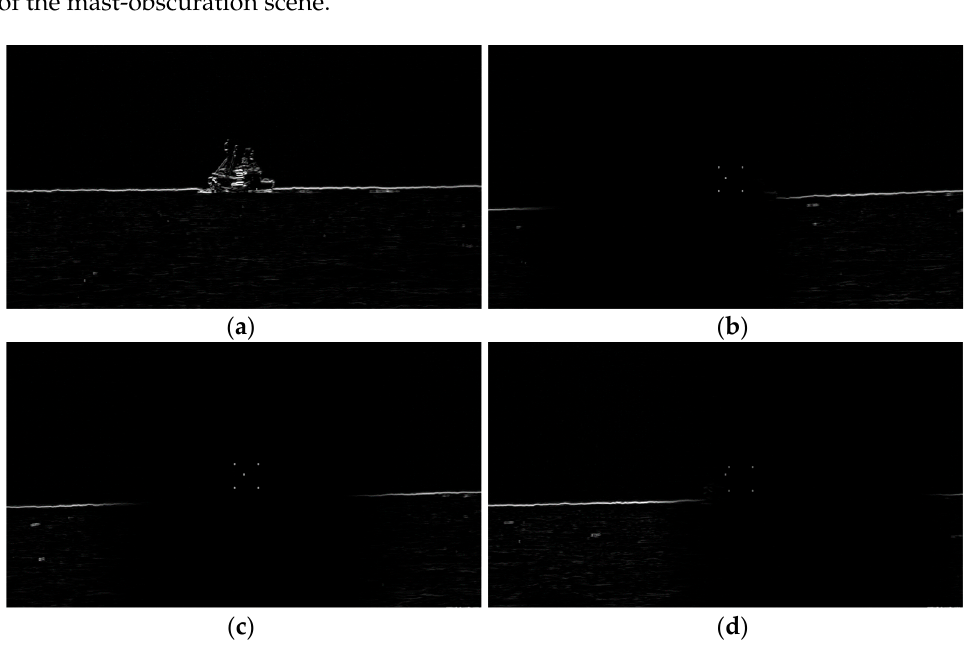
Figure 8. Edge detection result of the mast-obscuration scene: ( a ) A scene before the object is obscured; ( b ) The scene 1 where the object is obscured; ( c ) The scene 2 where the object is obscured; ( d ) The scene 3 where the object is obscured.